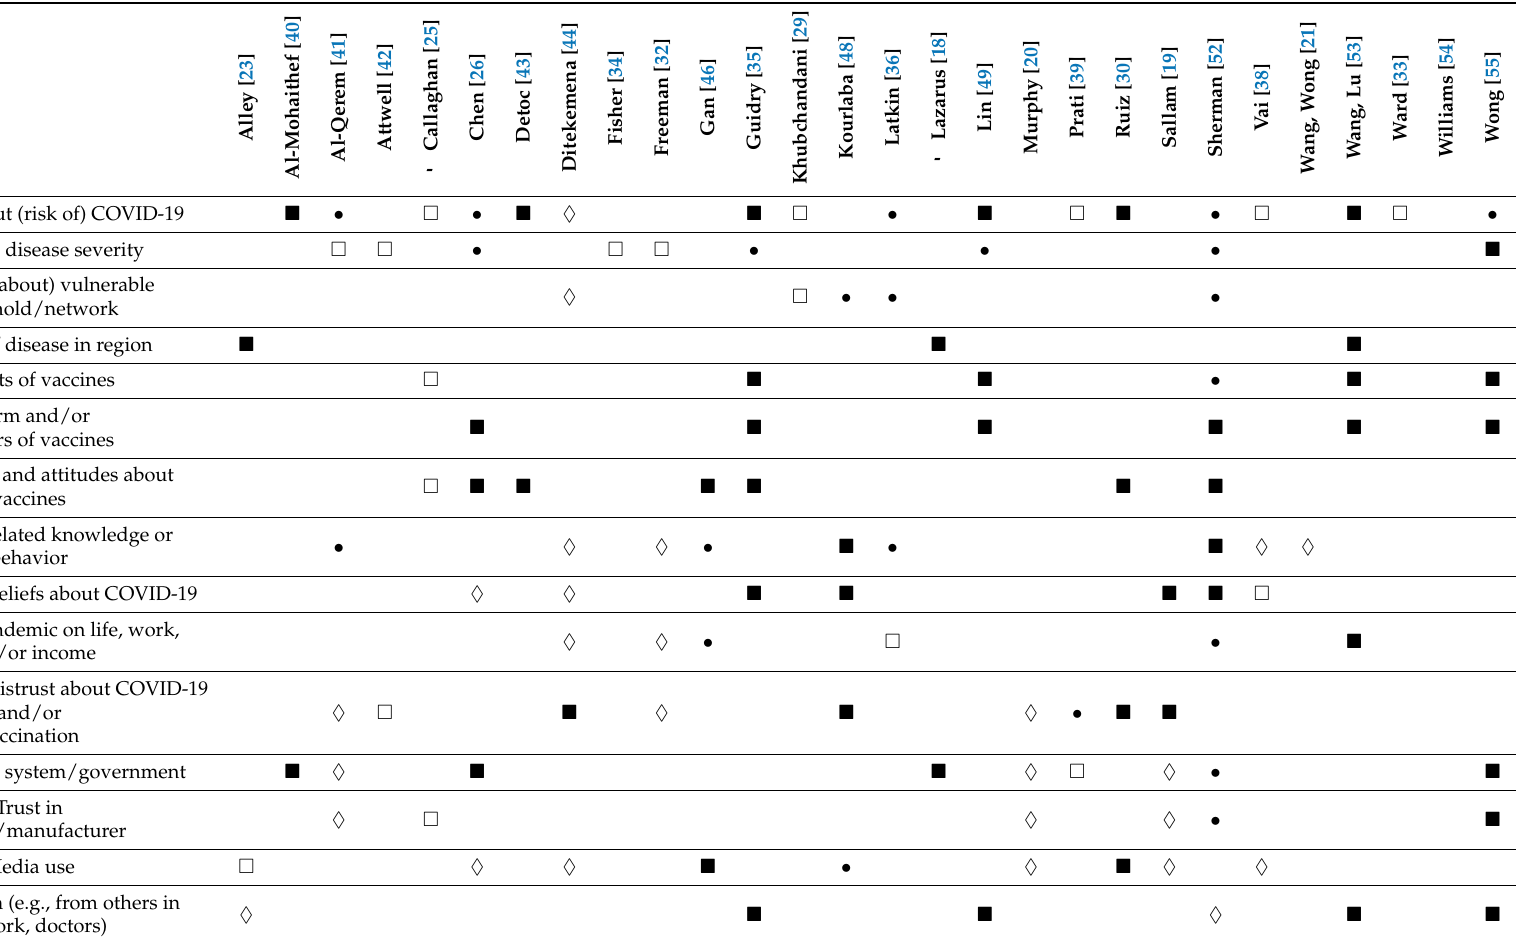
Table 4. Selected articles (sorted by first author) and studied determinants of vaccine acceptance or hesitancy and/or